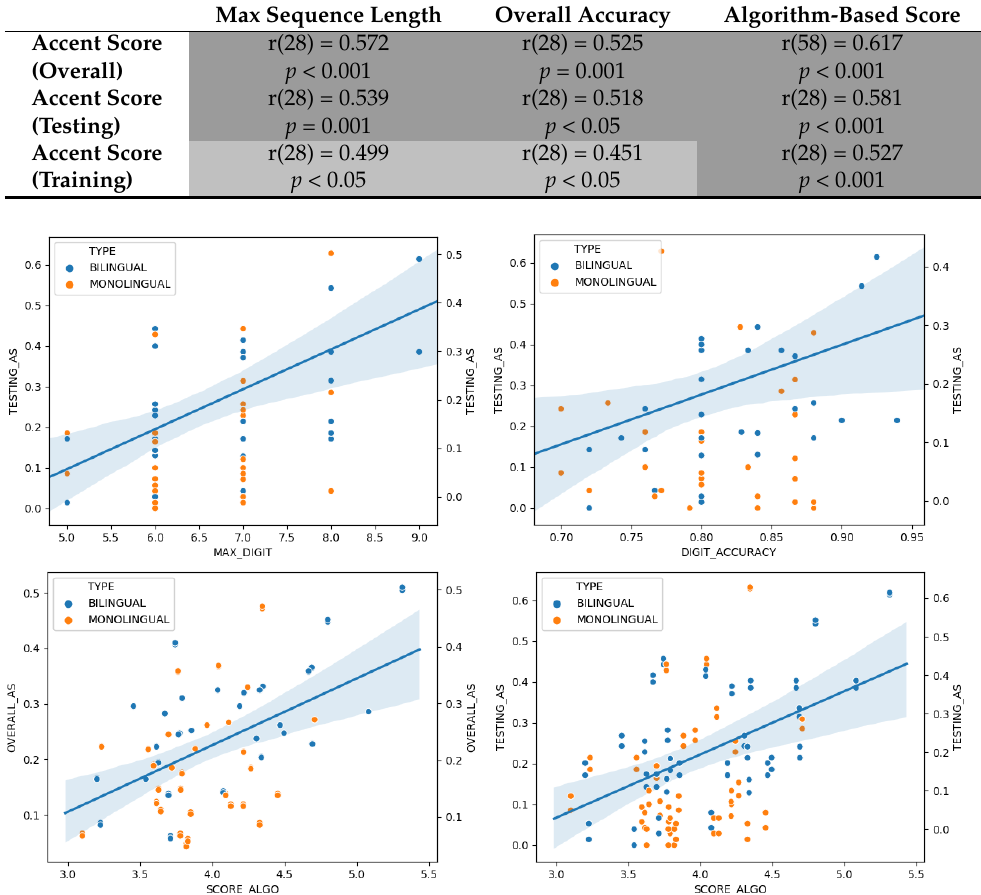
Figure 8. Regression plots for pairs of variables reflecting phonetic and phonological learning (Testing AS, Overall AS) and variables associated with auditory sensory memory (Max Digit, Digit Accuracy, and Score Algo). AS = accent score. Max Digit = maximum sequence length reached. Digit Accuracy = overall accuracy obtained in the digit span task, Score Algo = the corrected algorithm-based score obtained by taking into account permutation errors, with bigger penalties for items displaced at longer